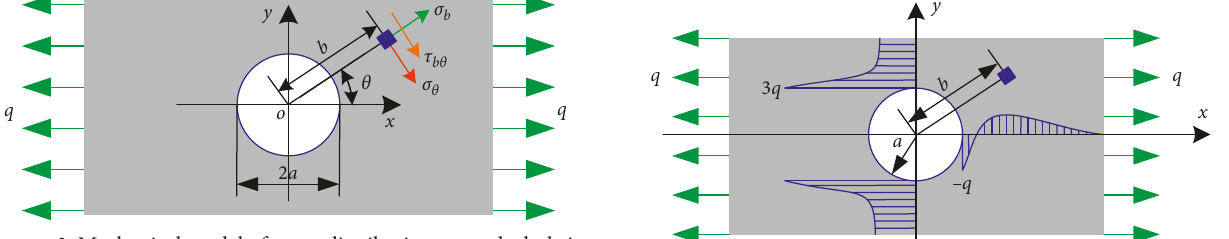
Figure 3: Mechanical model of stress distribution around a hole in the infinite rock